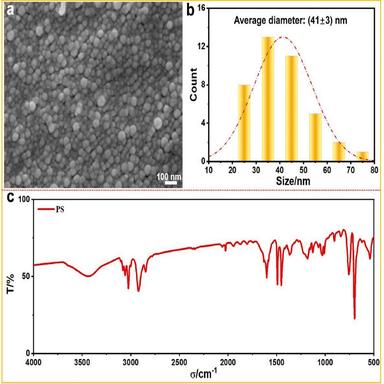
a) SEM image of nano-PS particles, b) grain diameter distribution of nano-PS particles, and c) FTIR spectra of nano-PS particles.